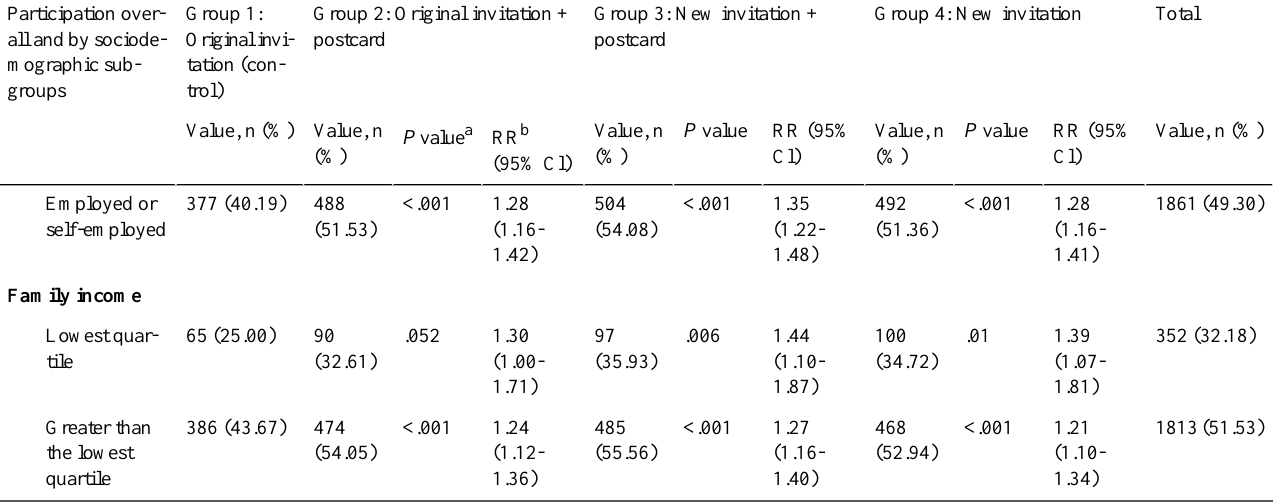
a P values for differences in the participation rate between the individual intervention groups (Groups 2-4) and the control group (Group 1).